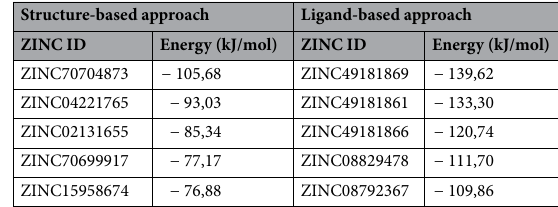
Table 2. Binding energies of the top “natural and derivatives” compounds after re-scoring using MMGBSA.